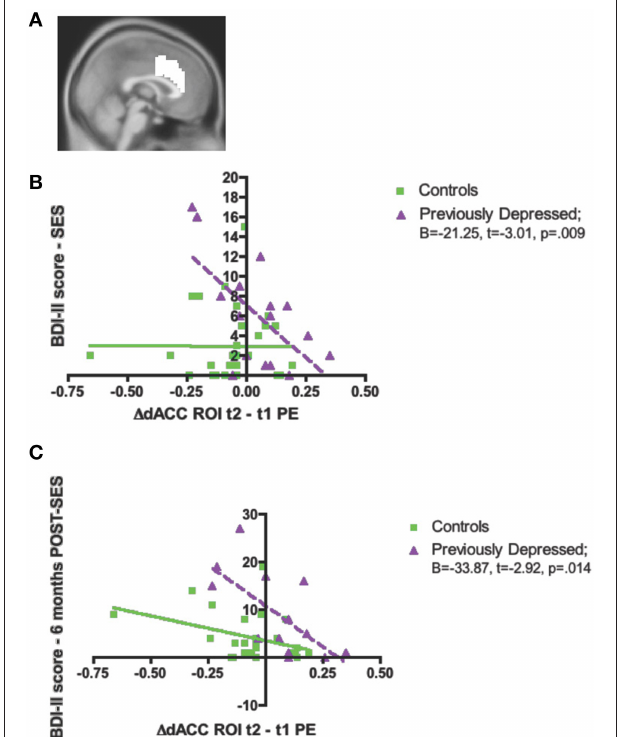
FIGURE 4 | Significant associations between the increase in activity over time in dorsal anterior cingulate cortex (dACC) independent, structural region of interest (ROI), and psychological measures in the previously depressed women compared to controls. (A) Sagittal view of the independent, structural dACC region of interest used to extract parameter estimates for subsequent analyses; (B) Beck Depression Inventory-II (BDI-II) score at the social evaluative session (SES); (C) BDI-II score at 6 months following the social evaluative session